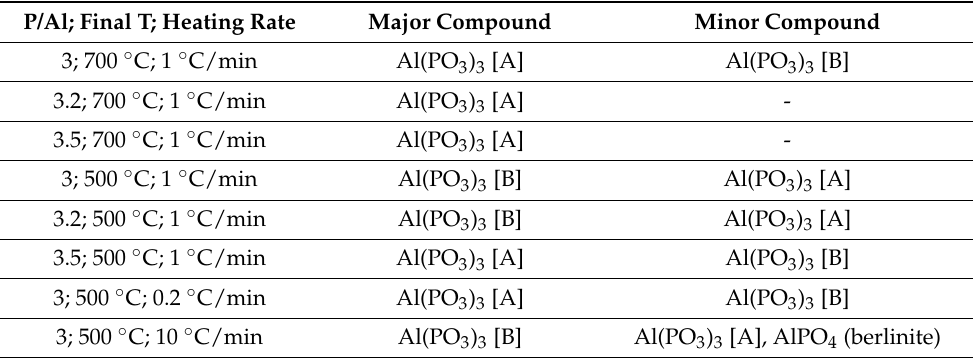
Table 4. Phases identified on the XRD experiments. Final T: final temperature. Only the data obtained on binders prepared with a dwell time of 1 h are reported